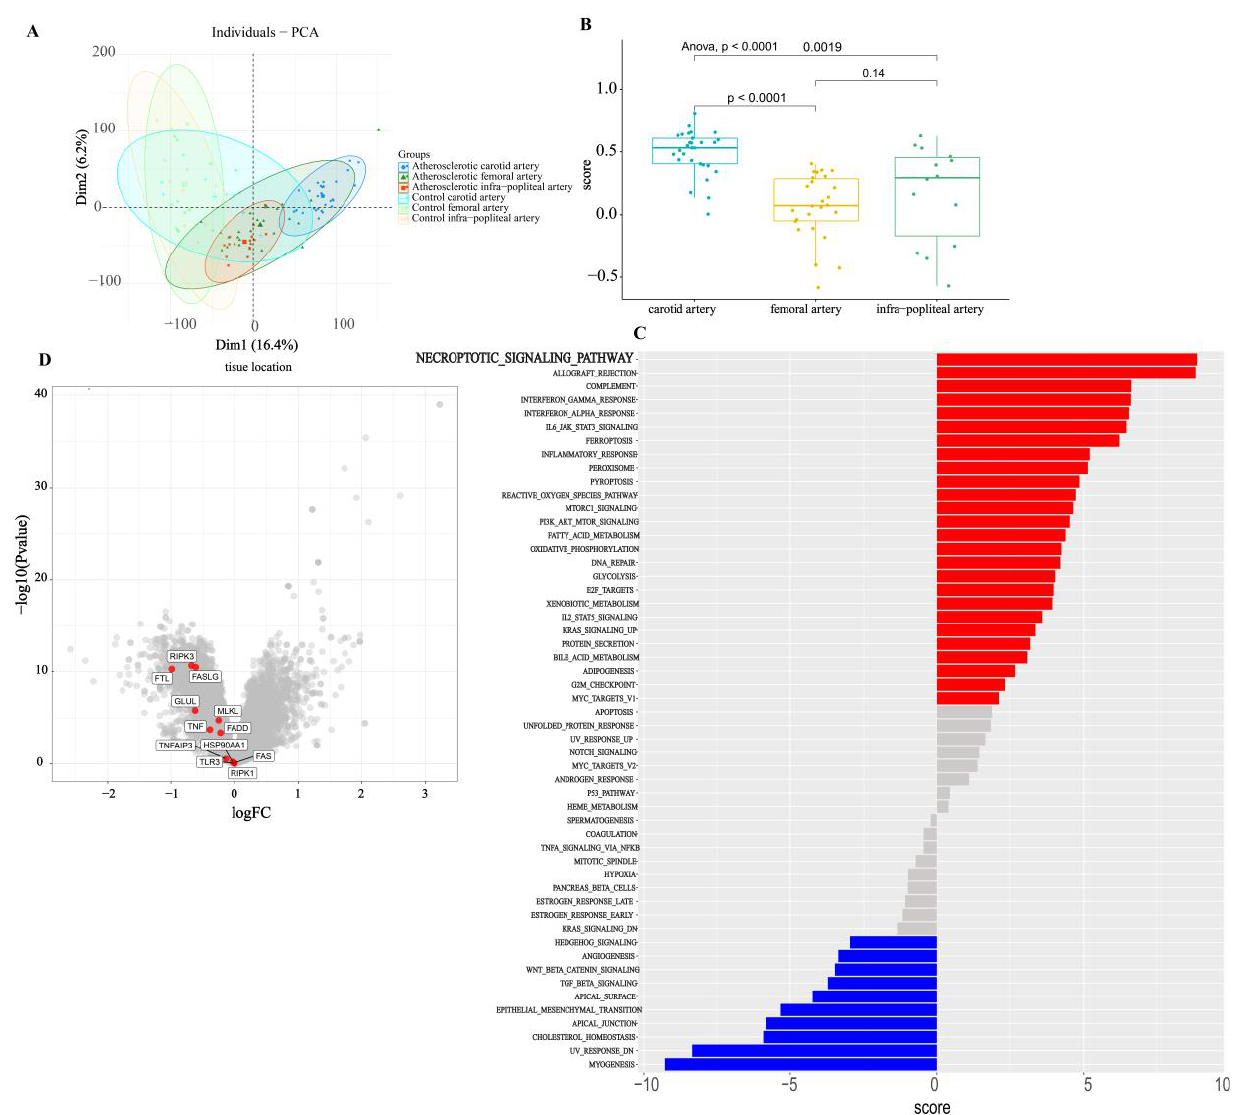
Figure 6. Results of transcriptome analysis of carotid and femoral artery samples. ( A ). PCA clustering results for carotid, femoral, and popliteal arteries. ( B ). Statistically significant differences were found in the immunoscores of carotid, femoral, and popliteal arteries. ( C ). The results of immunoscores for carotid and femoral samples are shown. The red items exhibit the more incredible immune response in the carotid samples. The blue color was more common in femoral samples. ( D ) The differentially expressed genes between femoral and carotid samples are represented in a volcanic map. Necroptosis-related genes are labeled in the